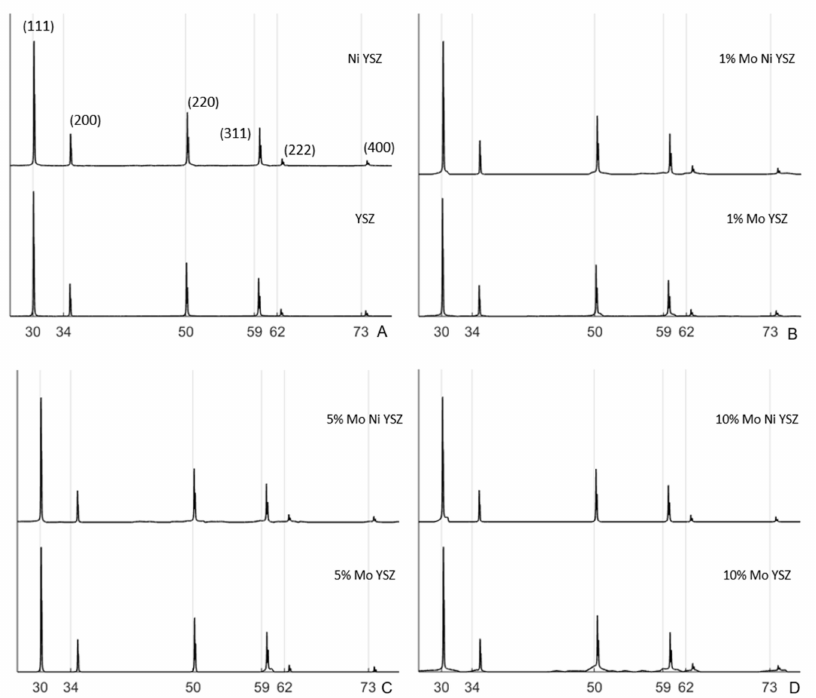
Figure 3. ( A ) XRD patterns with indexed peaks of cubic YSZ (YSZ), and cubic YSZ with Ni(NO 3 ) 2 infiltration sintered at 1200 ◦ C for one hour, and XRD patterns of 8YSZ with the addition of ( B ) 1, ( C ) 5, and ( D ) 10 mol.% MoO 2 and Ni(NO 3 ) 2 also sintered at 1200 ◦ C for one hour. Each pattern is as indicated its plot. Peaks are indexed for cubic YSZ